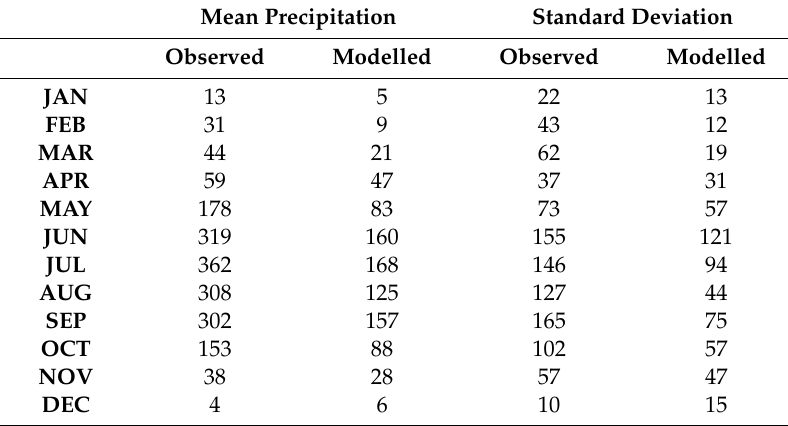
Table A2. Comparison of observed and meteoblue monthly mean precipitation and standard deviation (in mm) for Khulna